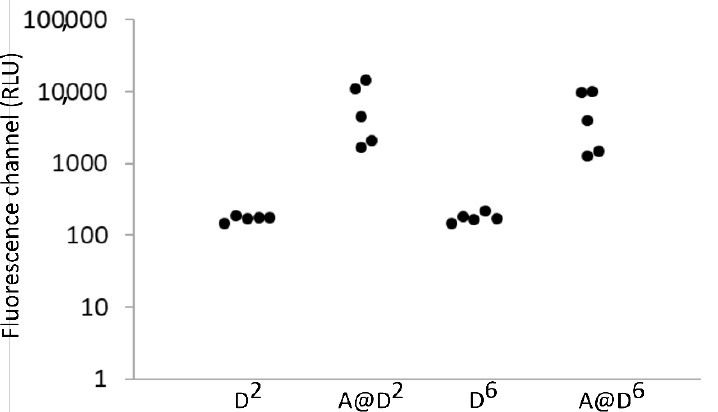
Figure 7. Mean fluorescence channel of D 2 , A@D 2 , D 6 , and A@D 6 dendrimers upon excitation with 405 nm laser. Fluorescence detection wavelength was 711 nm.